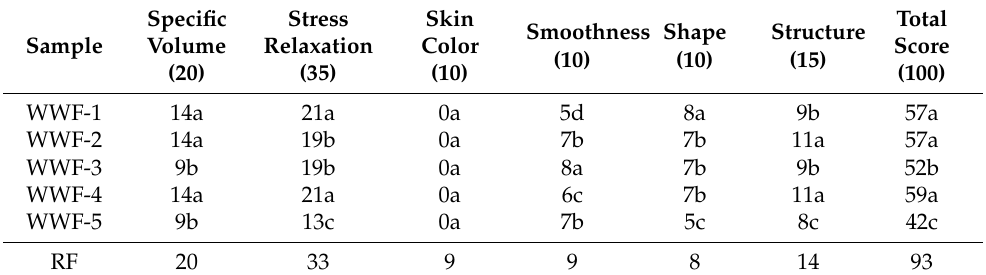
Table 4. Sensory evaluation for Chinese steamed bread produced from WWF obtained by different milling